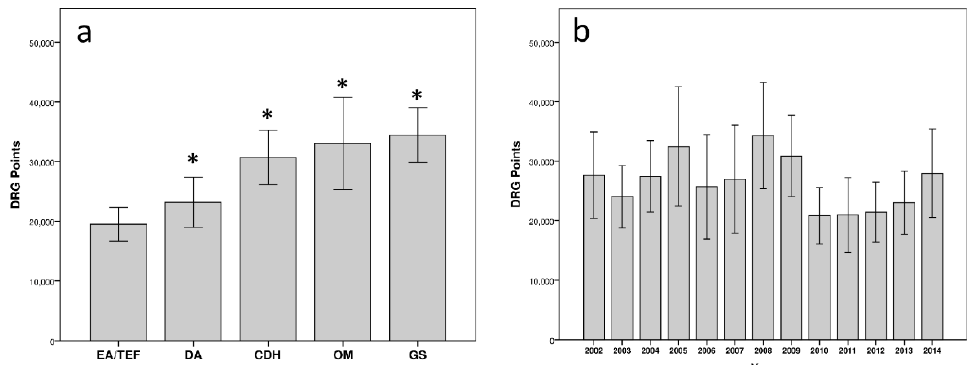
Figure 3. ( a ) Mean DRG points of the five selected malformations, the values for EA/TEF were significantly lower than those for all other malformations (* p < 0.05 vs. EA/TEF), abdominal wall defects represented the most expensive malformations. ( b ) Over the years, there was relatively even distribution of mean DRG points for all malformations together.